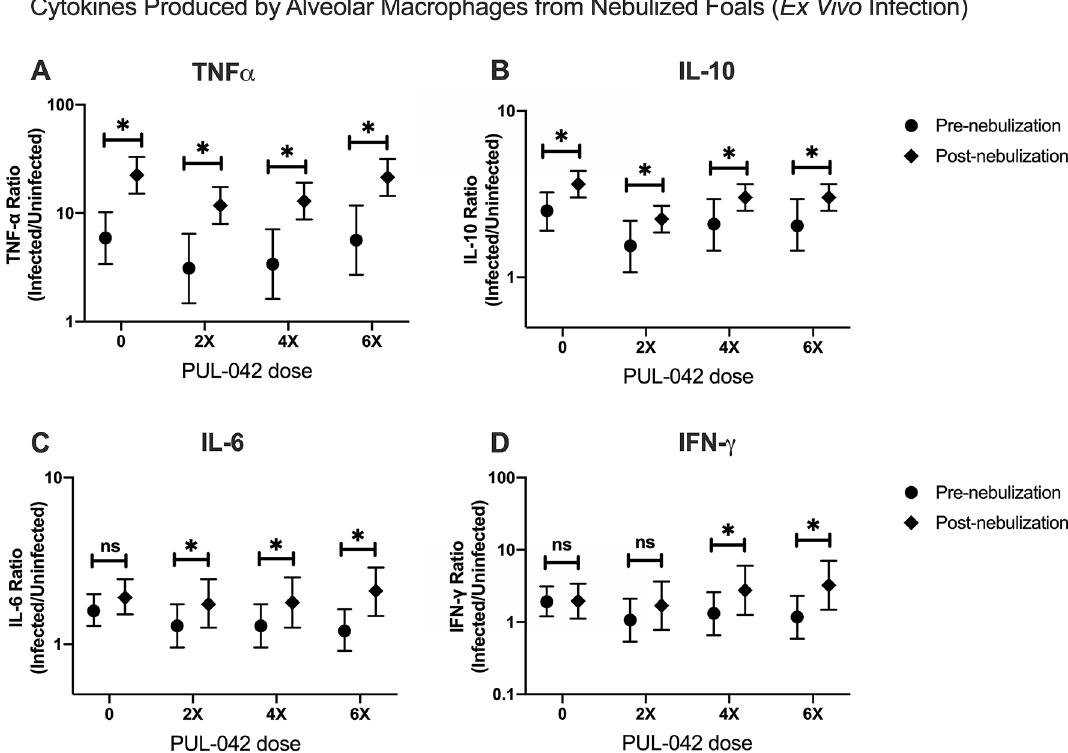
Figure 4. Concentration of pro- and anti-inflammatory cytokines in supernatants obtained from cultured alveolar macrophages (AMs) from foals before (age 2 days; Pre-nebulization) and after (age 28 days; Post- nebulization) nebulization with glycerol 2.8% (PUL-042 0; n = 12), and varying doses of PUL-042 (2X, n = 12; 4×, n = 12; 6×, n = 12). All foals were nebulized and no foals were infected in vivo with Rhodococcus equi . Broncho-alveolar lavage was performed pre- (day 2 after birth) and post-nebulization (day 22, 1 day after the last nebulization): AMs were infected with virulent R. equi using a multiplicity of infection of 10 bacteria per macrophage (infected) or kept in media only (uninfected). Supernatant was collected 48 h post-infection for determination of cytokine concentration by ELISA. Data represented as estimates of mean (95% CI); values were analyzed as ratios of R. equi -infected/uninfected cells to account for cytokine production at baseline (control uninfected). Upon ex vivo infection with R. equi , both cytokines TNF- ⍺ ( A ) and IL-10 ( B ) ratios significantly increased for all groups post-nebulization, while IL-6 ratio significantly increased only after treatment with PUL-042 ( C ). For INF-γ, this significant increase was only observed for the 2 higher doses of PUL-042, 4× and 6× ( D